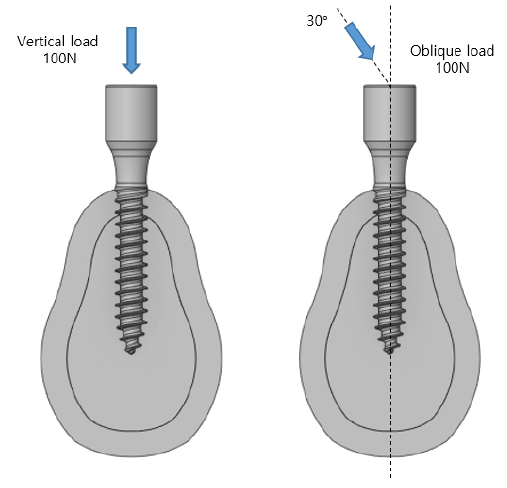
Figure 3. Axial, oblique loading condition.